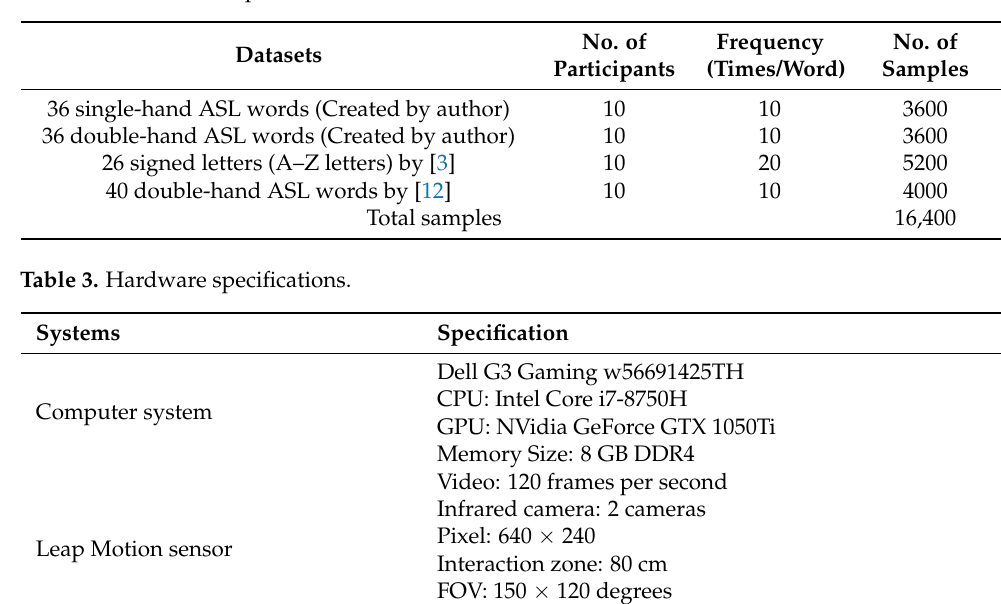
Table 2. Dataset description.